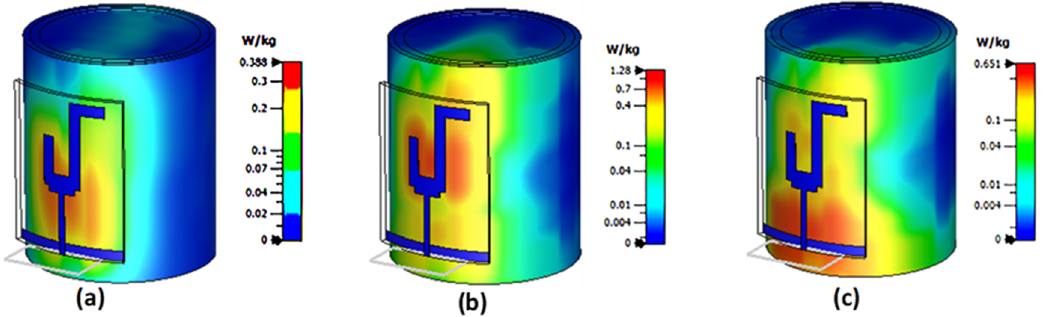
Figure 27. SAR 1g distribution for cylindrical phantom ( a ) 2.45 GHz, ( b ) 5.8 GHz, and ( c ) 8.0 GHz.